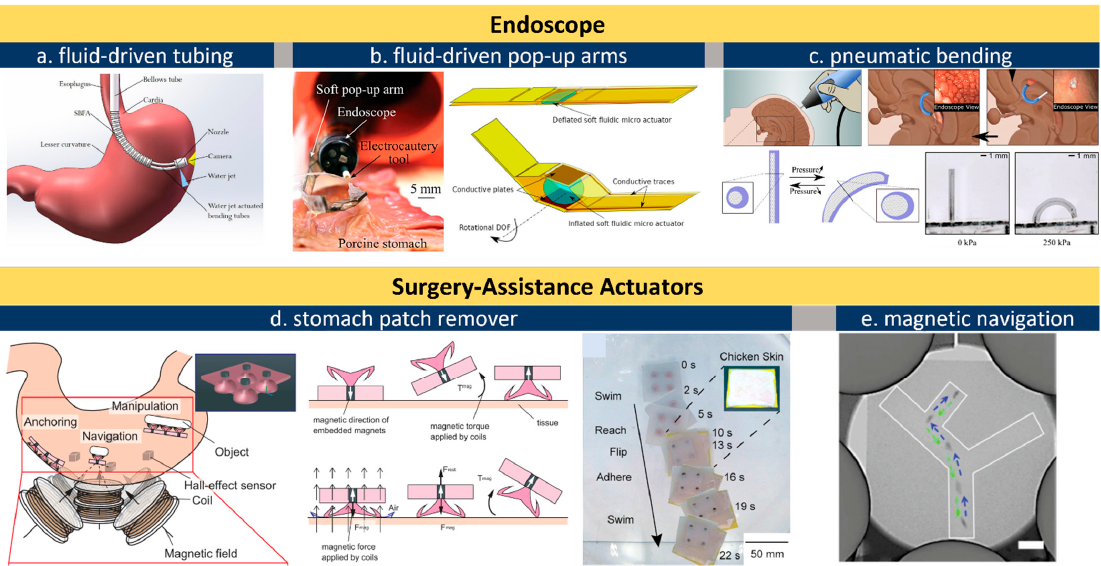
Figure 3. Actuators for endoscopes. ( a ), schematic illustration of the fluid line in a wired endoscope kit [110]; ( b ), an endoscope equipped with soft pop-up arms [44,48]; ( c ), pneumatically inflated actuation of intracranial endoscope [92]; ( d ), a magnetic soft vacuum sucker to remove surgery patch in stomach [106]; ( e ), x-ray navigation of magnetic actuators under skin [102]. All images are reproduced or adapted with permission.